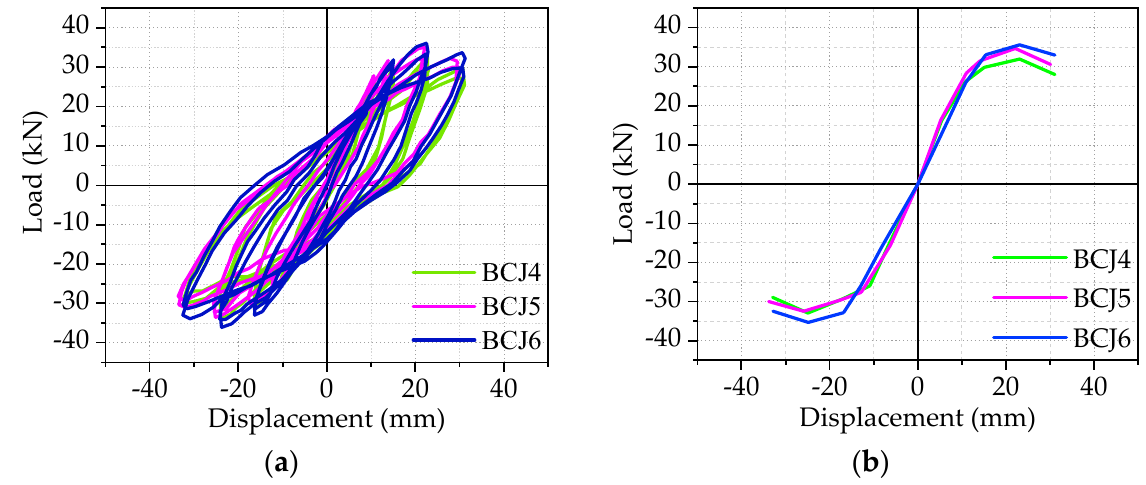
Figure 12. The effect of axial compression ratios: ( a ) Hysteretic curve; ( b ) Skeleton curve.